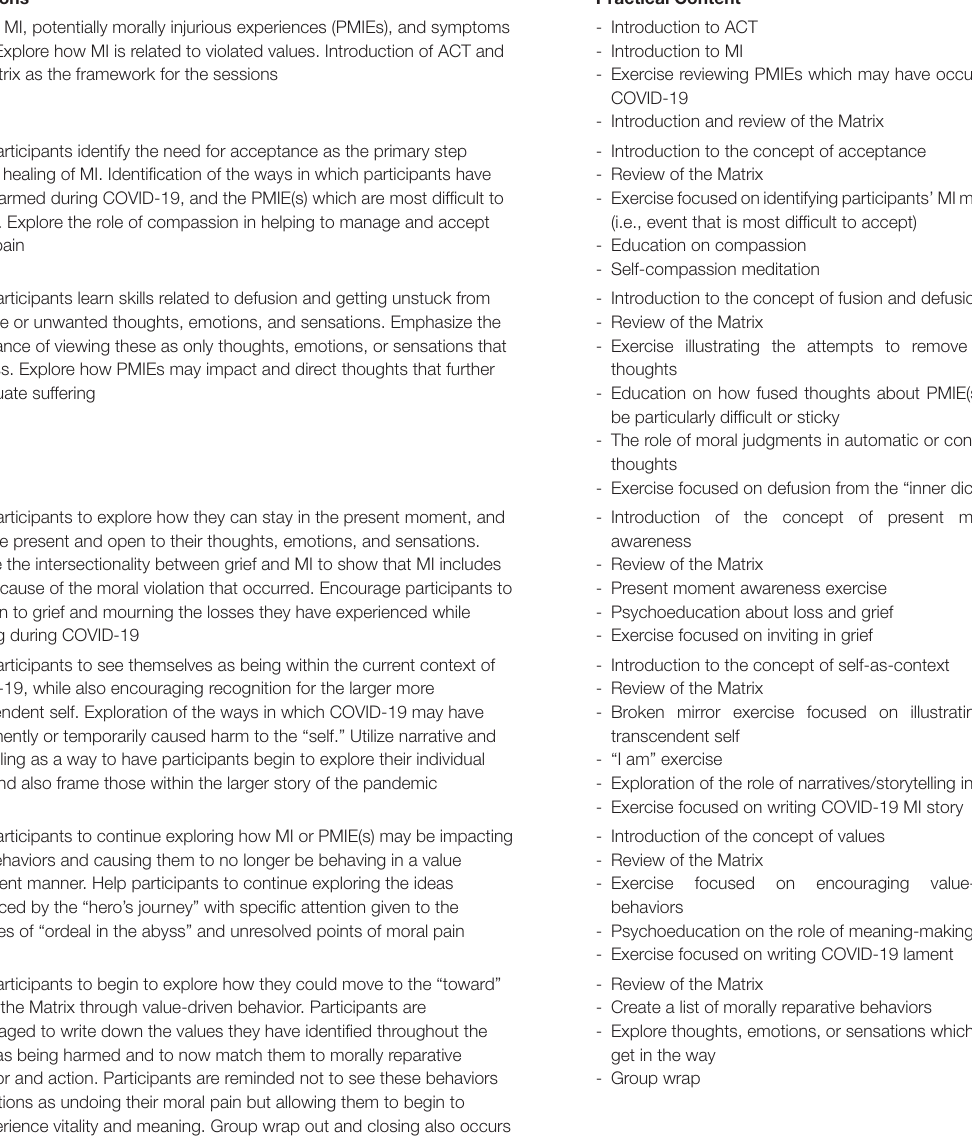
TABLE 1 | Summary of AMPS-HCP